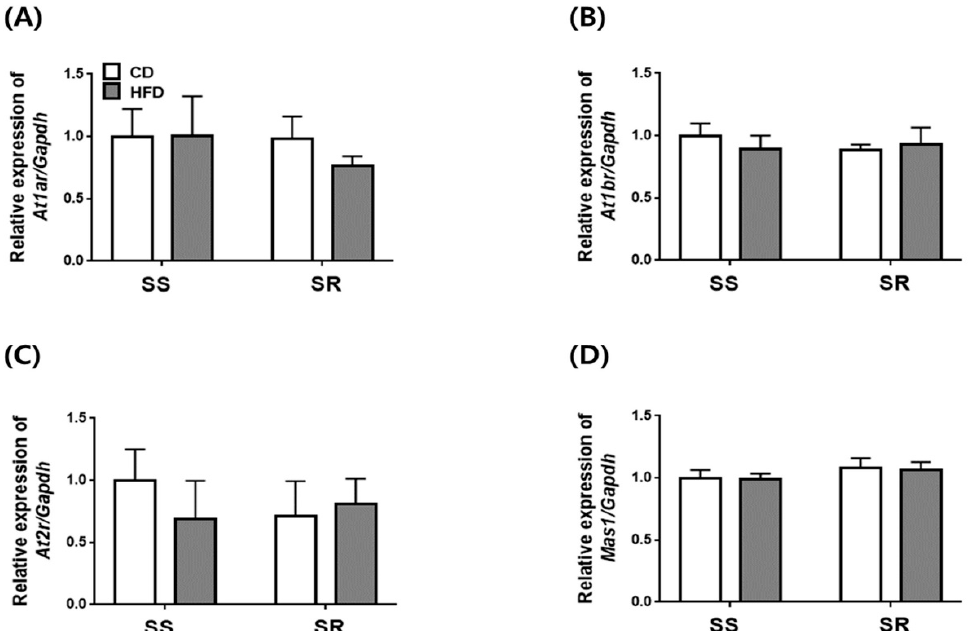
Figure 7. The effects of a high-fat diet on the expression of genes related to angiotensin II receptor in kidney from SS and SR rats. The mRNA expression of angiotensin receptor related genes such as angiotensin II type 1a receptor ( At1ar , A ), angiotensin II type 1b receptor ( At1br , B ), angiotensin II type 2 receptor ( At2r , C ), and mas1 proto-oncogene ( Mas1 , D ) were measured by RT-qPCR in kidney from SS and SR rats fed a CD or HFD for 12 weeks. Graph, mean ± SEM of 6 independent experiments. Two-way analysis of variance followed by Tukey’s post hoc multiple comparisons test.